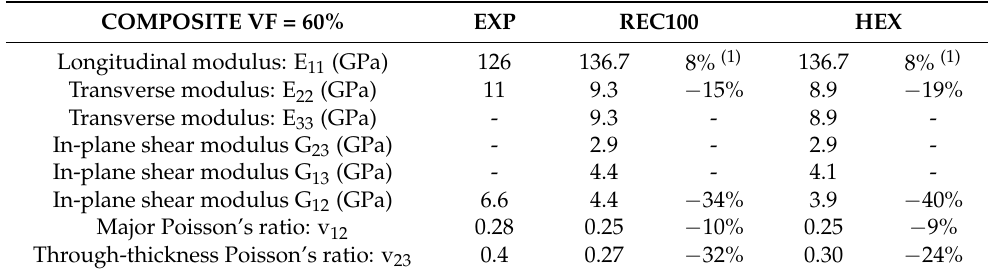
Table 5. Comparisons between the measured experimental (EXP) and the predicted effective proper- ties for HEXAGONAL and RECTANGLE with R = 1.0 (square) RUCs.